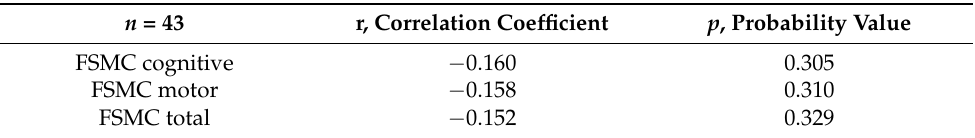
Table 5. Correlation by Spearman-Rho of circulating NfL level and fatigue severity in patients with positive anti-NR2 antibody titer (>2 ng/mL) n =